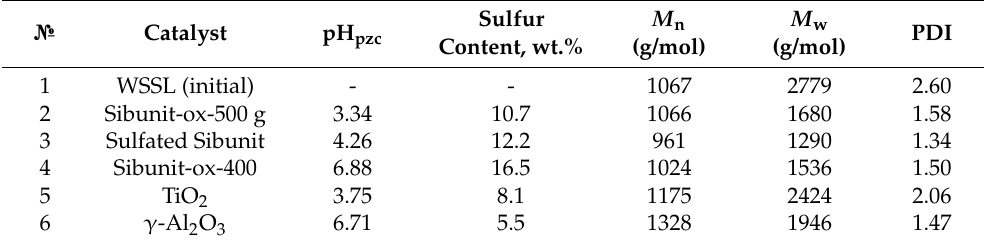
Table 1. Effect of the catalysts on the sulfur content, weight average molecular weight M w , and